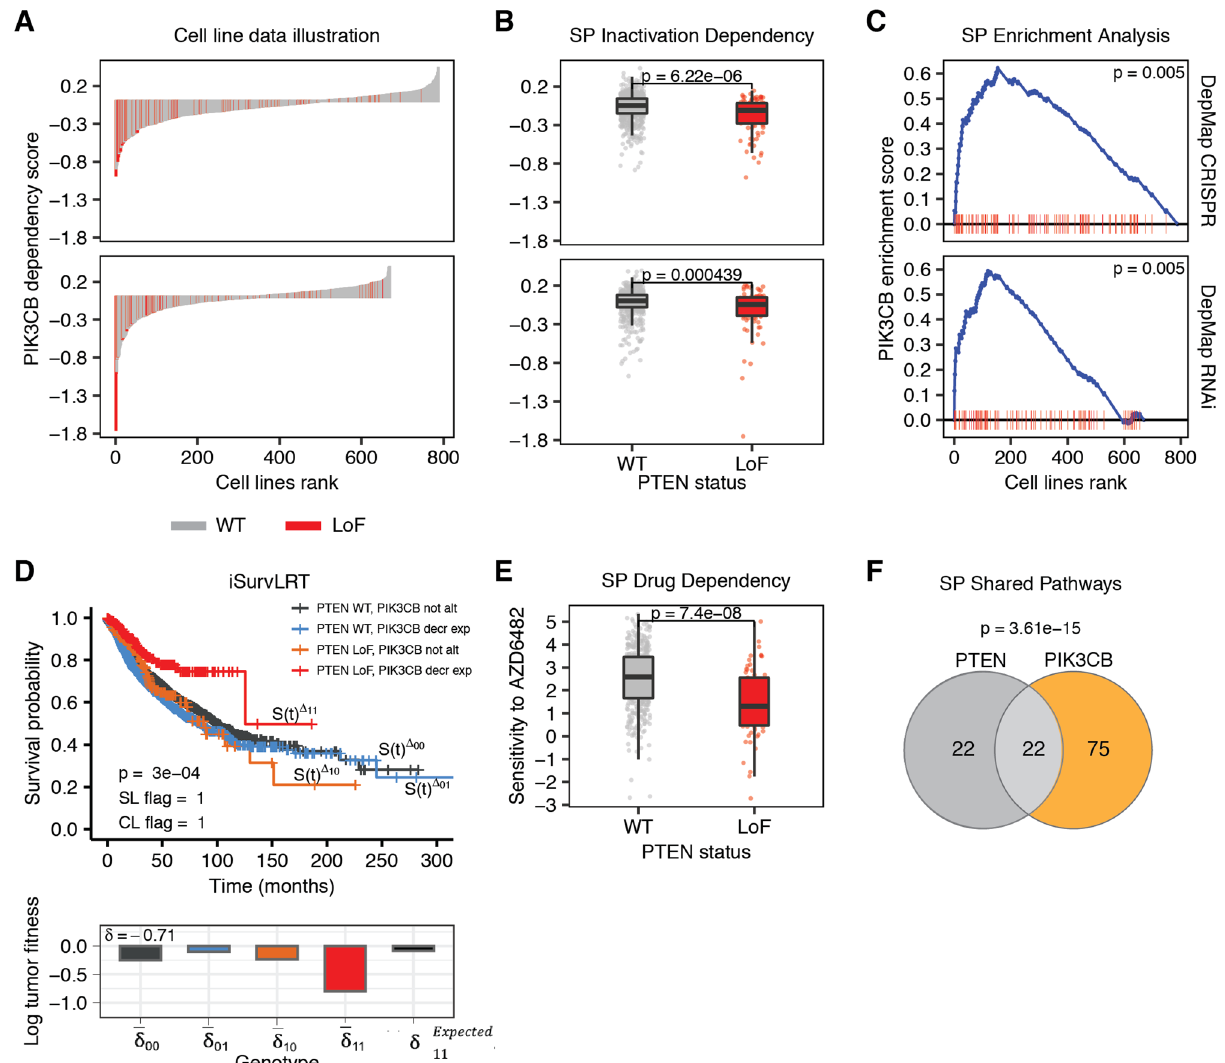
Figure 3. Evidence found in cell line, patient, drug and pathway data for the PTEN and PIK3CB SL interaction. Plots illustrating the results of tests that confirmed (significant p-value) the SL interaction between the pair. ( A ) Waterfall plots for Achilles (first row) and DEMETER2 (second row) datasets, illustrating the results of PIK3CB knock-out experiments in cancer cell lines (sorted according to the effect size, cell lines having PTEN LoF marked in red; x axis) with knock-out effect measured by dependency score (negative effect means that cells proliferate worse after the knock-out, positive - the cells proliferate better; y axis). ( B ) Boxplots illustrating SPID test results for Achilles (first row) and DEMETER2 (second row) datasets (y axis same as for panel A). ( C ) Plots illustrating SPEA test results for Achilles (first row) and DEMETER2 (second row) datasets; cell lines are sorted according to the dependency score (cell lines having PTEN LoF marked in red; x axis); the blue line illustrates the calculations of PIK3CB enrichment score (global maximum being the measured ES; y axis) that increases when encountering a cell line with PTEN LoF, and decreases when encountering cell line with WT PTEN . ( D ) The Kaplan-Meier survival plots illustrating iSurvLRT test result with survival time in months (x axis) and calculated survival probability (y axis); the effect size for different PTEN genotype and PIK3CB expression Expected level combinations measured by log tumor fitness are shown below, δ 11 value representing the effect size expected without SL interaction for double PTEN and PIK3CB LoF genotype. ( E ) Boxplots illustrating SPDD test result for GDSC dataset; the cells sensitivity to drug targeting PIK3CB is measured by natural logarithm of IC50 (ln(IC50)) (y axis). ( F ) Venn diagram illustrating SPSP test result with the number of common PTEN and PIK3CB pathways printed in the